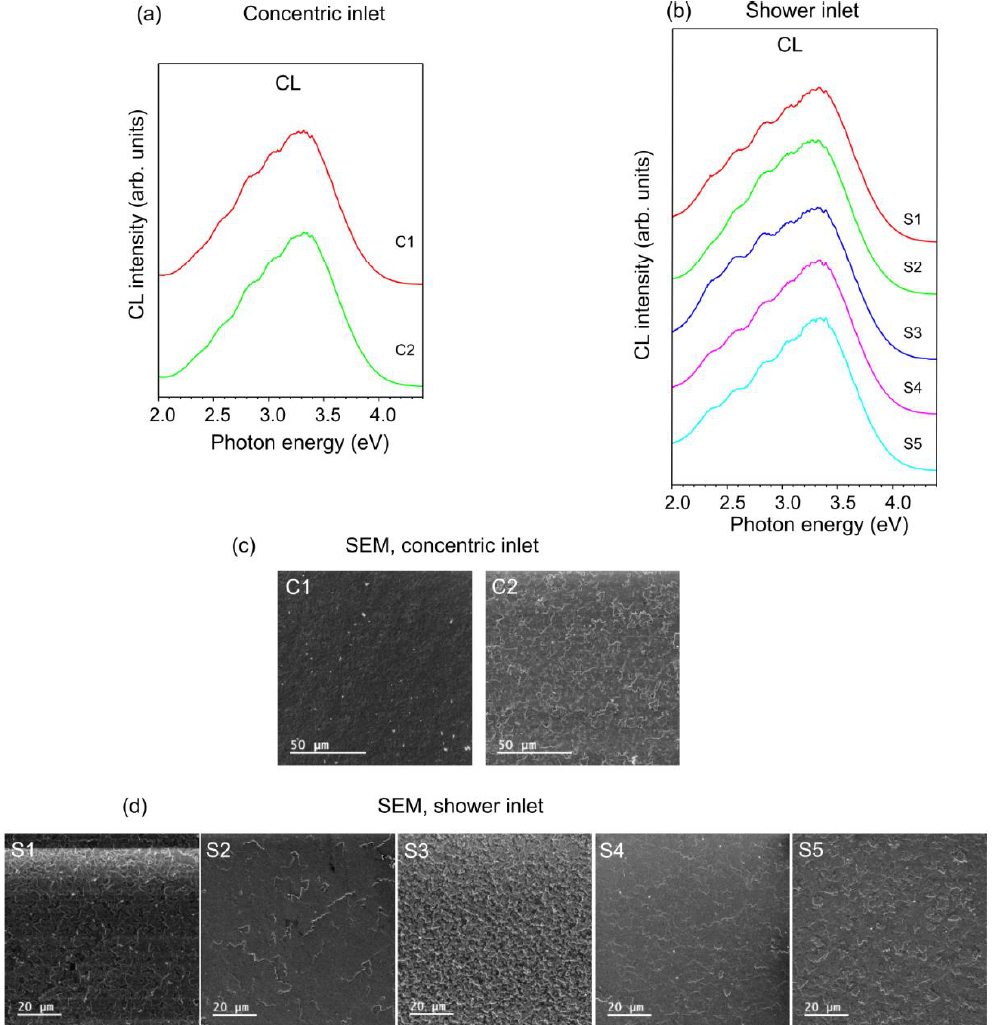
Figure 7. CL spectra measured at room temperature for β -Ga 2 O 3 layers grown using a tube ( a ) and a shower head ( b ) as the GaCl inlet. The spectra are normalized and shifted along the vertical axis for clarity. The SEM images show the areas where the CL spectra were acquired for each sample in the case of a ( c ) concentric and ( d ) shower inlet.